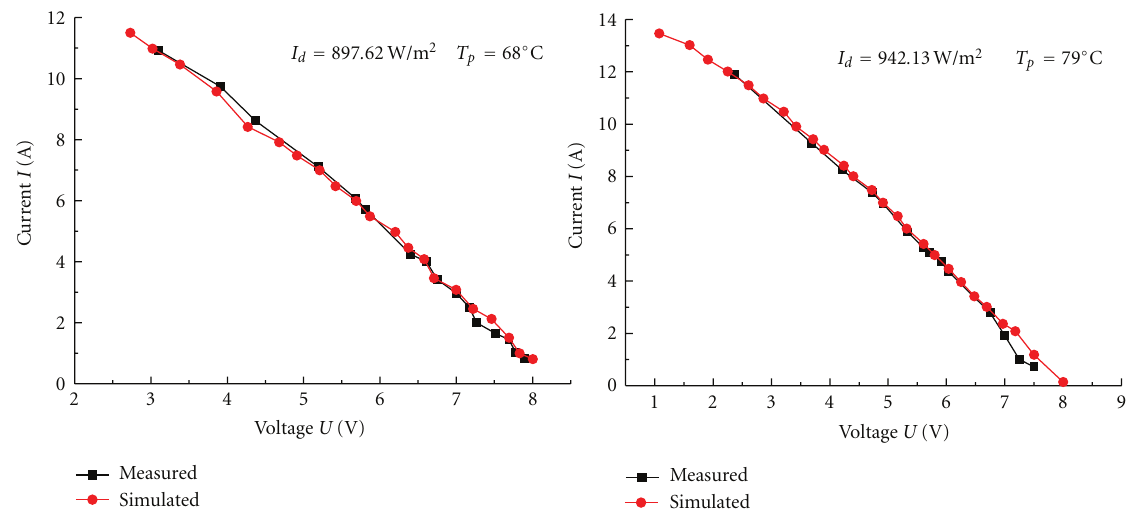
Figure 5: The I-V characteristics of the super cell array comparisons between experiments and simulations.